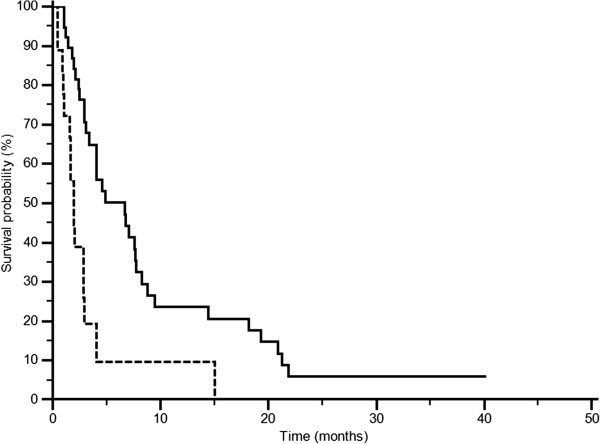
PFS according to LDH pre-treatment: LDH ≤ 407 U/l (———), LDH >407 U/l (--------) (p = 0.0002).